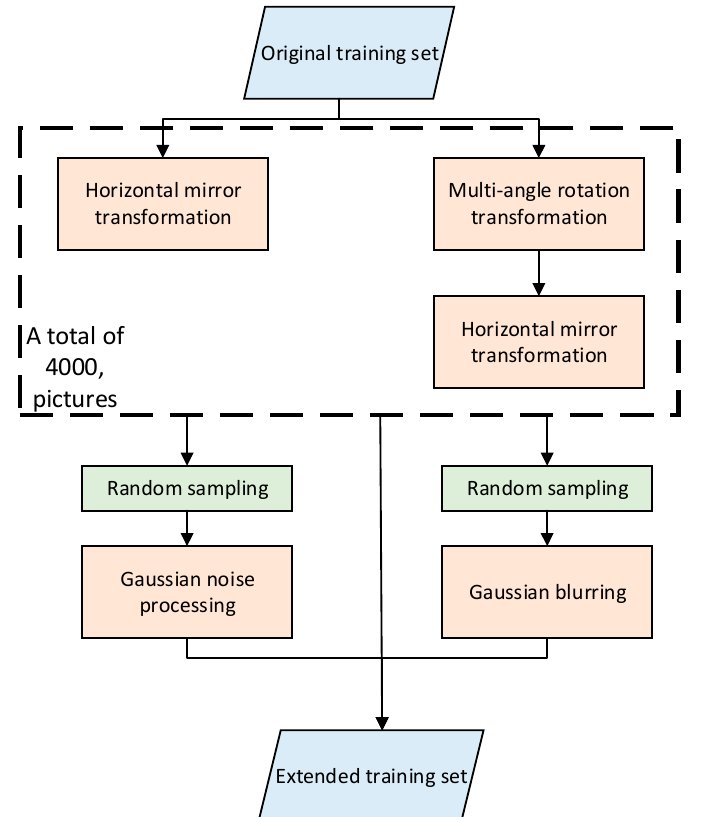
Figure 7. Flowchart of data augmentation.